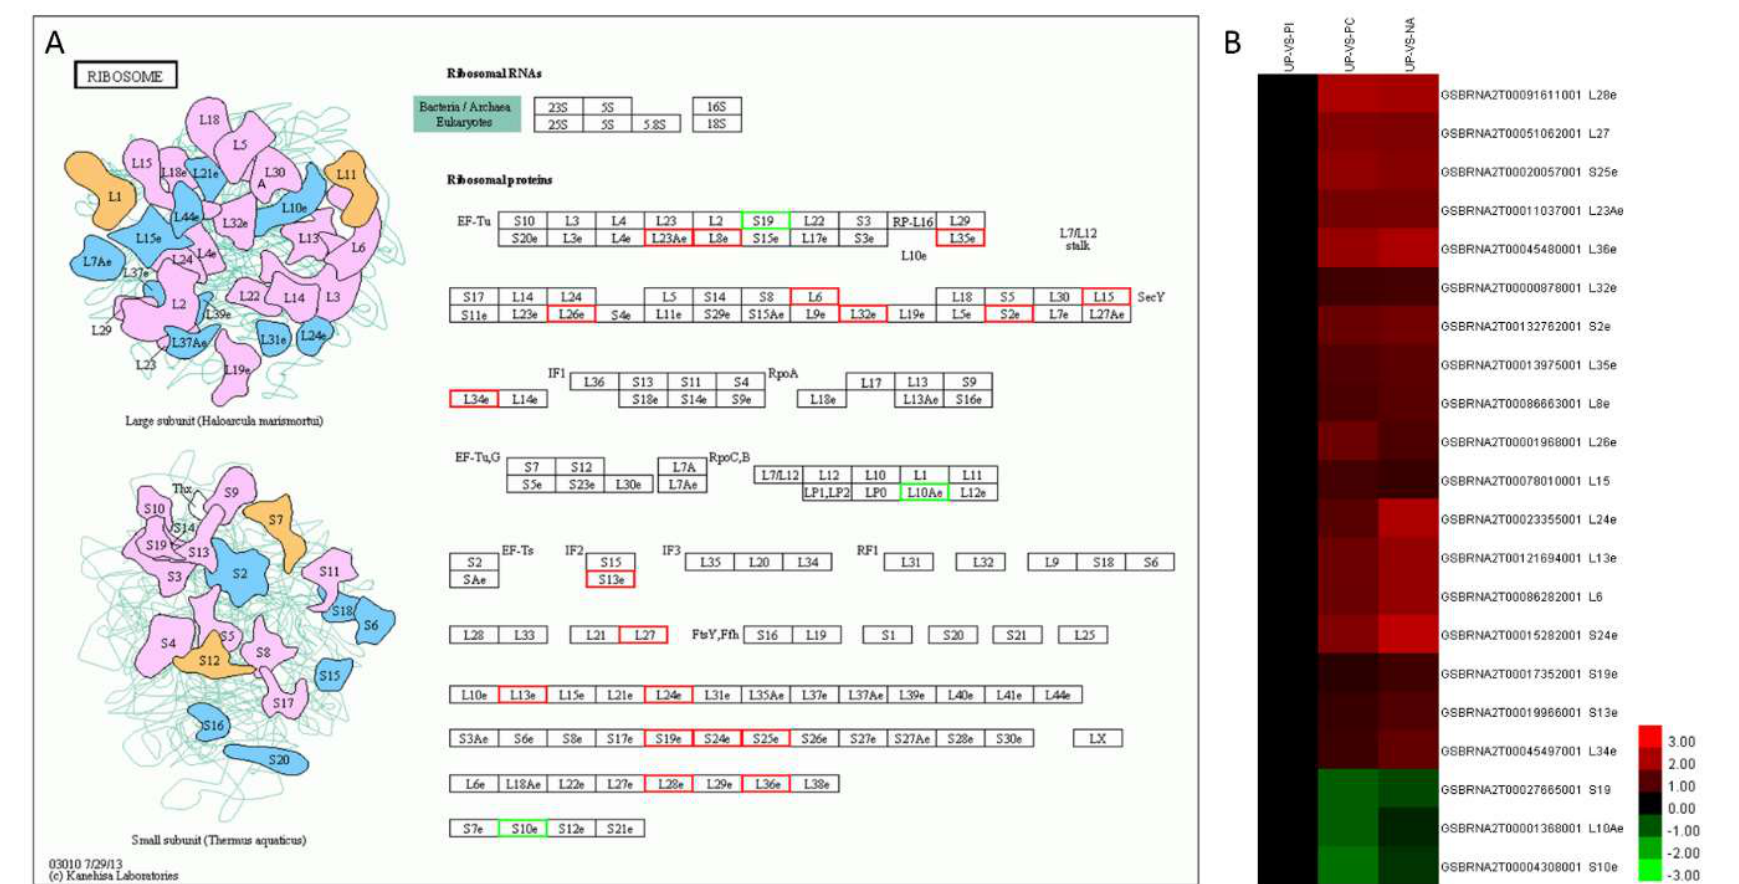
Figure 6. The overlapping differentially accumulated proteins between UP-VS-PC and UP-VS-NA enriched in the ribosome. ( A ) Twenty-one proteins mapped to ribosome, red box indicates up-accumulated protein, green box indicates down-accumulated proteins; and ( B ) heat map of the 21 differentially accumulated proteins; red means up-accumulated and green means down-accumulated.